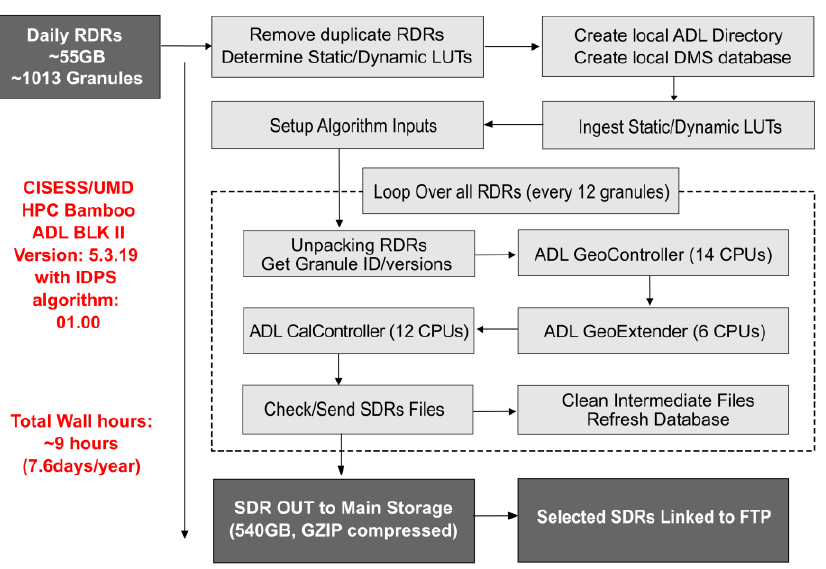
Figure A2. Flow-chart of VIIRS sensor data record (SDR) reprocessing using the